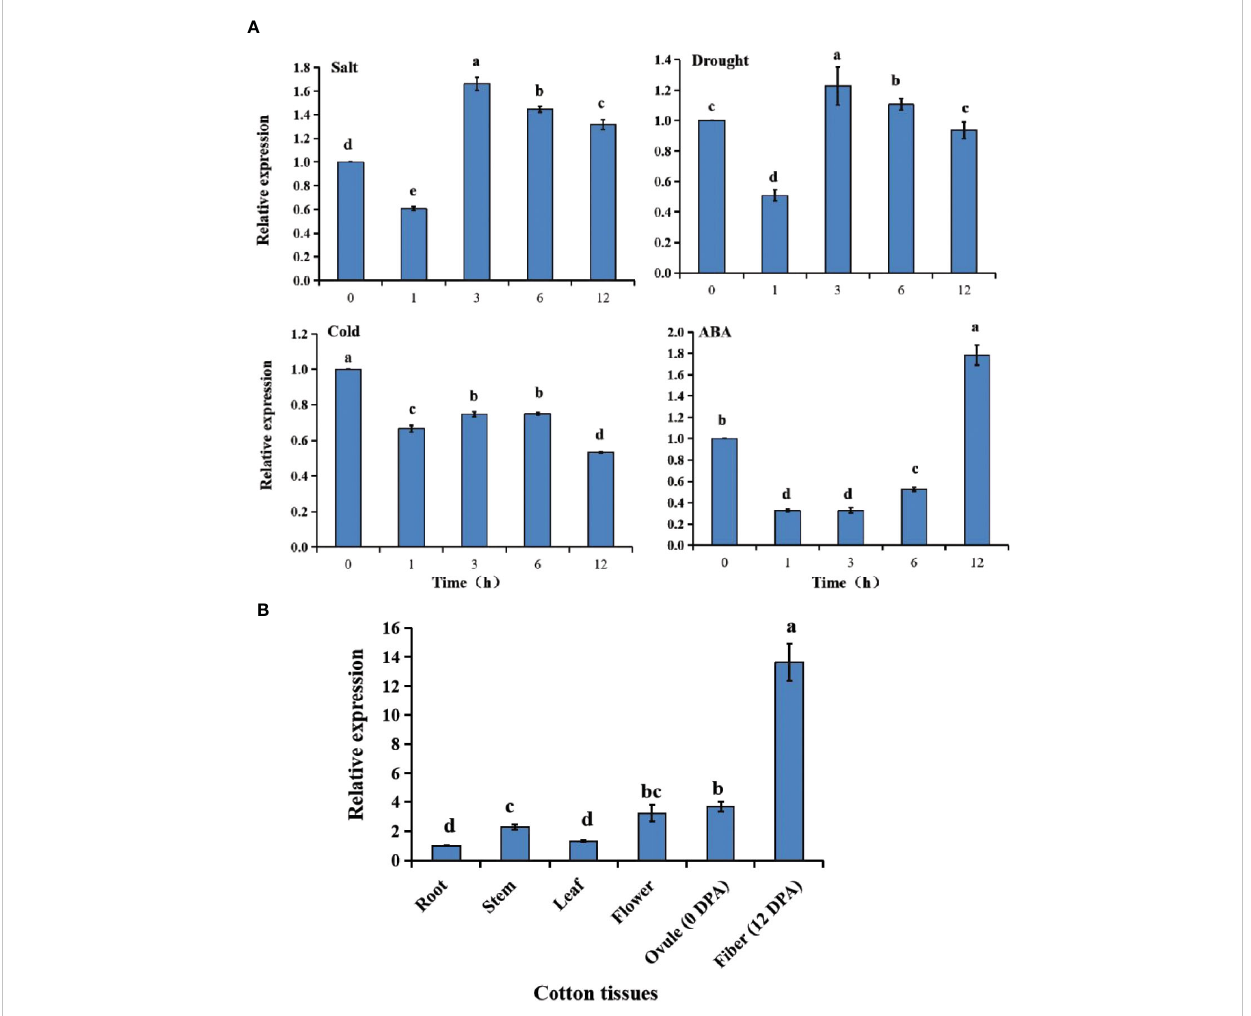
FIGURE 3 The expression of the GhGT23 gene in response to different stresses and ABA treatment as well as in different tissue types. (A) Expression of GhGT23 in cotton seedlings in response to ABA treatment and different stresses. The 0-h expression level was arti fi cially set to 1. (B) GhGT23 expression in various cotton plant tissues. The expression of GhGT23 in the root was arti fi cially set to 1. DPA, days post-anthesis. Different letters indicate signi fi cant differences (p < 0.05) determined using ANOVA, followed by Duncan ’ s multiple comparison